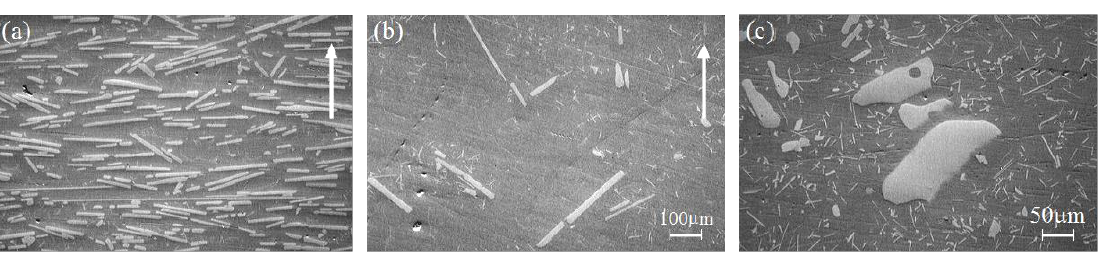
Figure 5. Microstructure of Al-Al Ti CSPM-FGM [15]. ( a ) Images were taken on a plane 3 perpendicular to the rotation axis in the outer; and ( b ) inner regions; ( c ) was taken on a plane perpendicular to the centrifugal force direction in the outer region of the ring.